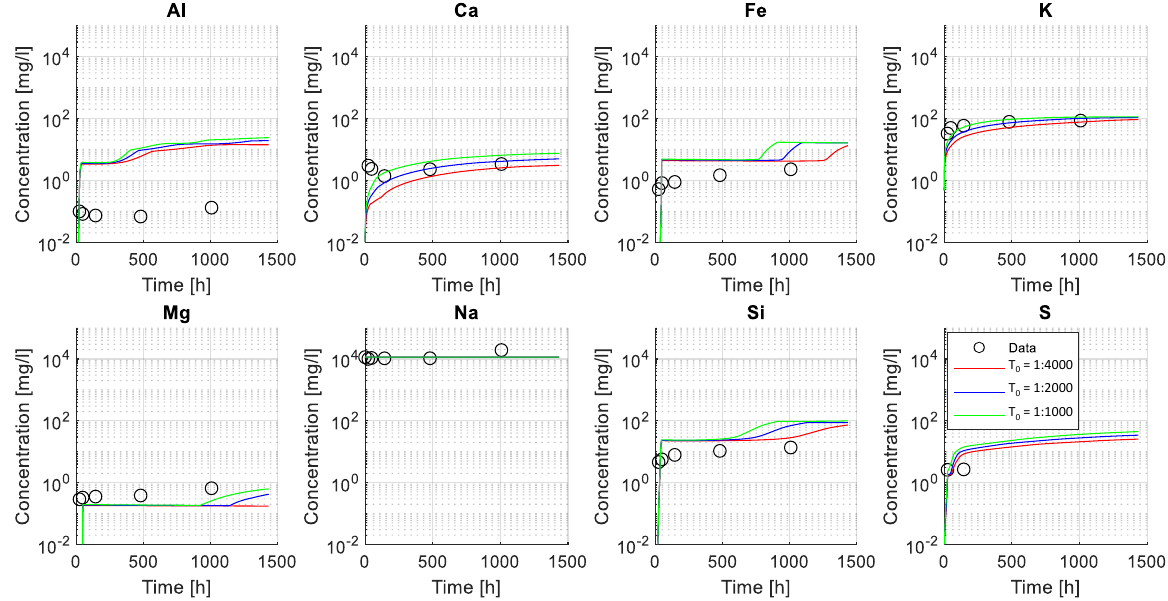
Figure 13. Validation of calibrated tortuosity factor. The figure shows the elemental concentration for selected ions in the exposure solution. Modeled results (lines) and experimental values (markers) are presented in mg/L in a logarithmic scale along the experiment time (presented in a linear scale). Modeled results are shown for three values of the initial tortuosity factor (T 0 ): T 0 = 1:1000, T 0 = 1:2000, T 0 = 1:4000.